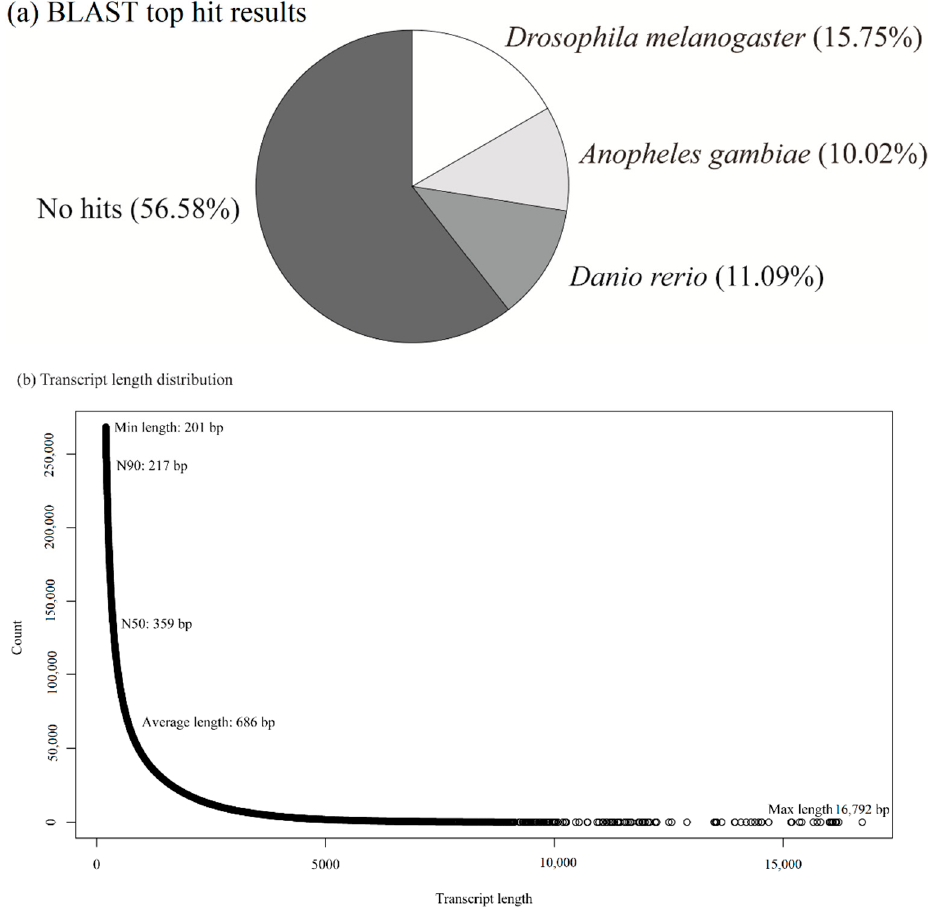
Figure 1. ( a ) BLAST top hit results and ( b ) transcript length distribution. N90: the minimum contig length to which the cumulative length from the largest contig covered 90 percent of the genome; N50: the minimum contig length to which the cumulative length from the largest contig covered 50 percent of the genome; bp: base pairs.